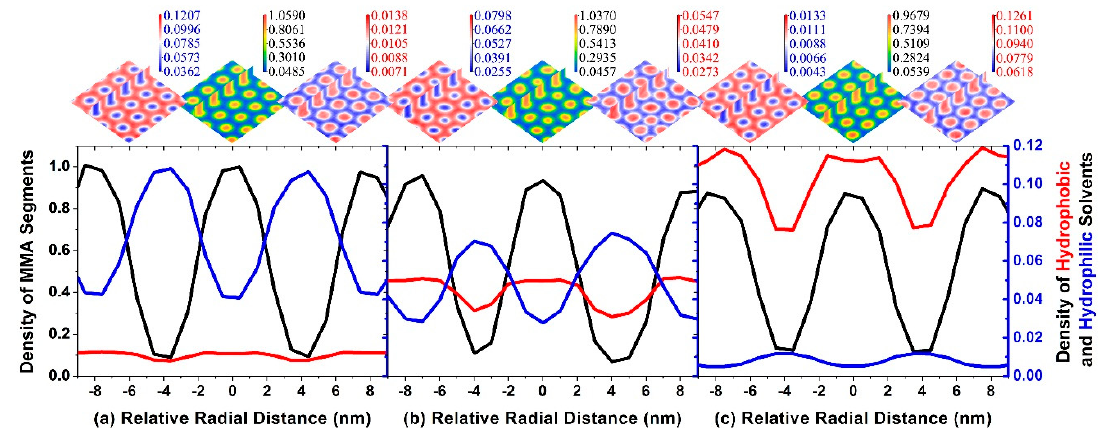
Figure 5. Density distributions of B beads (denoted with a black line), hydrophobic solvent beads (denoted with a red line) and hydrophilic solvent beads (denoted with a blue line) in the radial direction of self-assembled cylinder arrays in three systems doped with binary solvent, corresponding to ( a ) the system doped with 10% hydrophobic solvent; ( b ) the system doped with 40% hydrophobic solvent; and ( c ) the system doped with 90% hydrophobic solvent. The density distributions of three types of beads along the thickness direction of the thin film are omitted for concise display. Three density-slice pictures are exhibited above each subfigure. They are pictures for the hydrophilic solvent beads (whose color mapping is in blue-white-red), the B beads (whose color mapping is in reverse rainbow) and the hydrophobic solvent beads (whose color mapping is in blue-white-red) from left to right, respectively. Additionally, for clarity, the captions are colored the same as they are in the corresponding density-distribution lines.